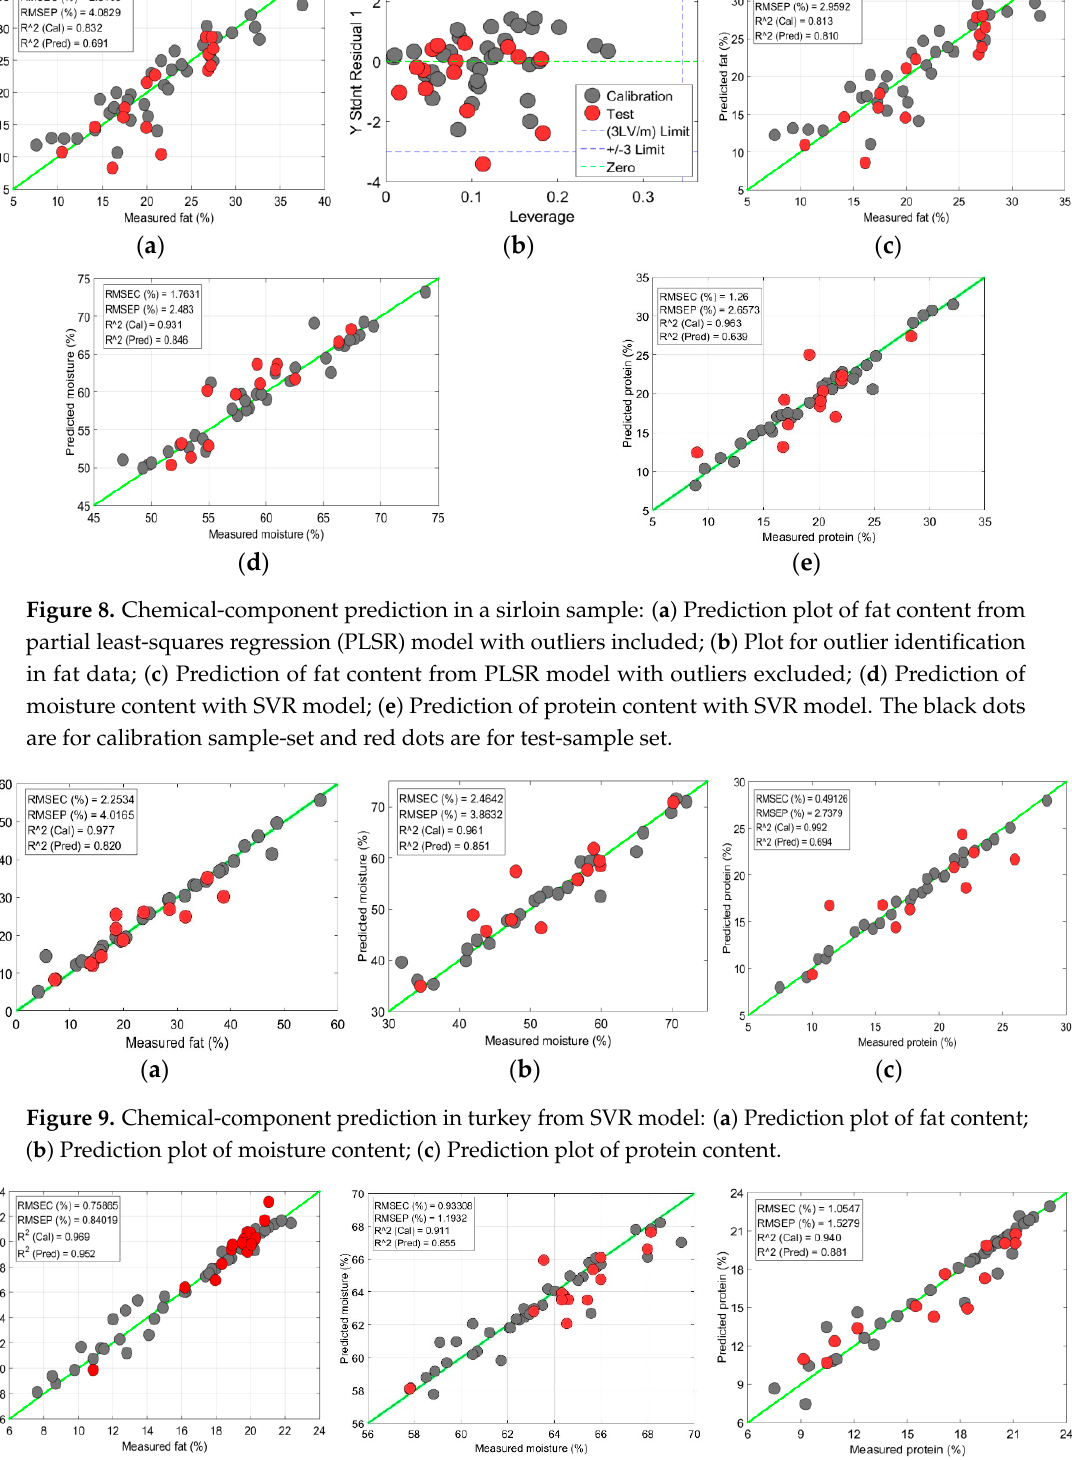
Figure 9. Chemical-component prediction in turkey from SVR model: ( a ) Prediction plot of fat content; ( b ) Prediction plot of moisture content; ( c ) Prediction plot of protein content. Figure 10. Chemical-component prediction in tenderloin from SVR model: ( a ) Prediction plot of fat content; ( b ) Prediction plot of moisture content; ( c ) Prediction plot of protein content. Table 2. Among all of the preprocessing methods, the SNV preprocessed data performed superior for